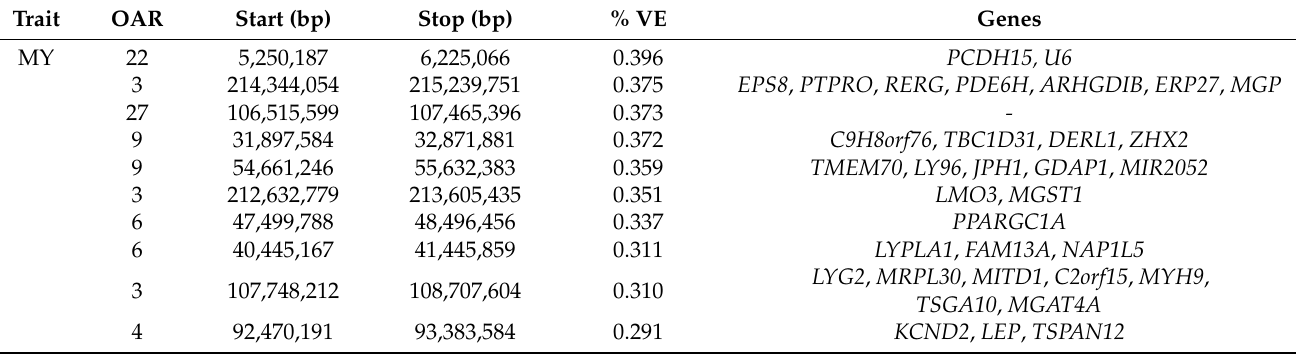
Figure 1. Manhattan plots of the additive genetic variance (%) explained by 1.0 Mb window of adjacent SNPs for milk production traits and SCS: ( A ) milk yield, ( B ) fat yield, ( C ) protein yield, ( D ) fat percentage, ( E ) protein percentage, and ( F ) SCS. Each dot represents a window. The top 10 ranked windows for each trait by that explained the largest proportion of additive genetic variance and the important candidate genes for all investigated traits are presented in Tables 2–5. The characteristics of these window regions for the six traits are explained in detail in the following paragraphs. Table 2. Identification of genes based on additive genetic variance explained by top 10 window regions for milk yield trait.